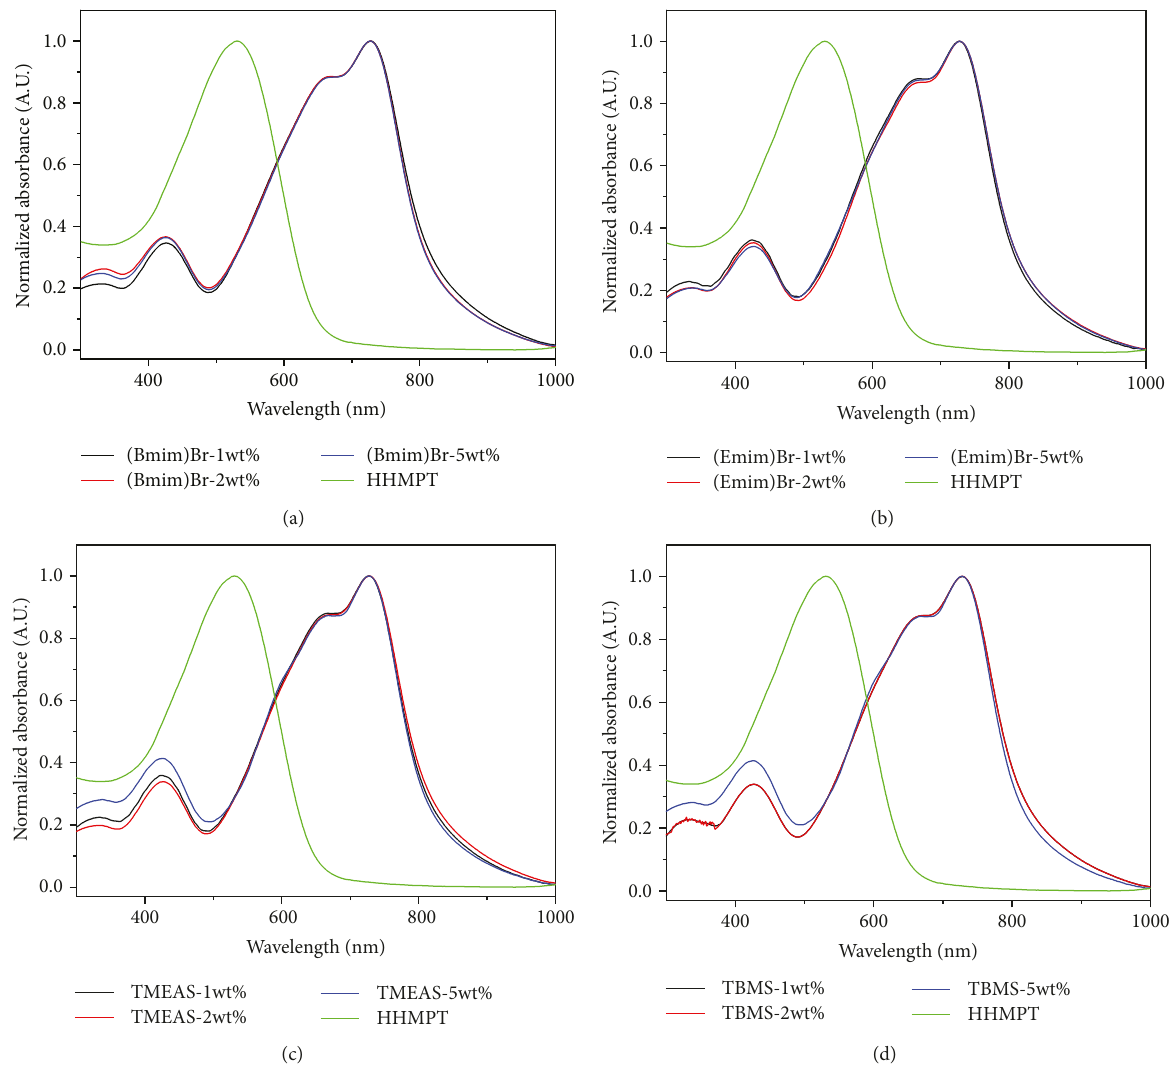
Figure 2: UV-Vis spectra of the polymer and polymer+ILs (1, 2, and 5 wt%) mixtures: (a) polymer +[Bmim]Br; (b) polymer+ [Emim]Br; (c) polymer+ TMEAS; (d) polymer